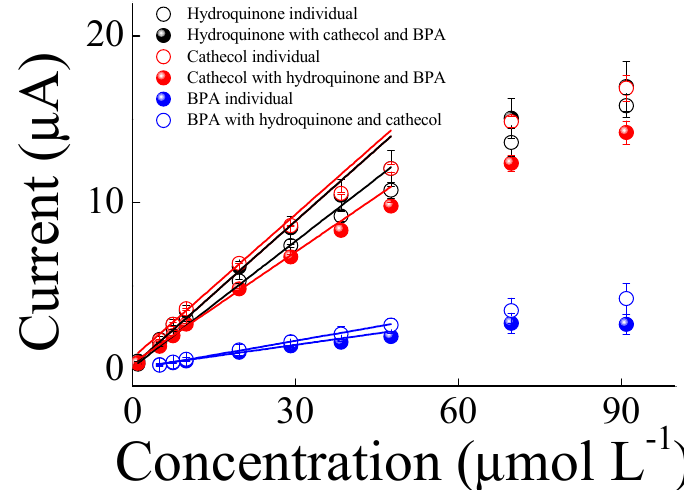
Figure 4. Di ff erential Pulse Voltammograms data for individual electrooxidation of hydroquinone in ( A ), catechol in ( B ) , and BPA in ( C ) , using flexible SPEs after electrochemical pre-treatment. Conditions: concentration range from 0.5 to 90 × 10 − 6 mol L − 1 in phosphate bu ff er solution 0.1 mol L − 1 , pH 7.0.